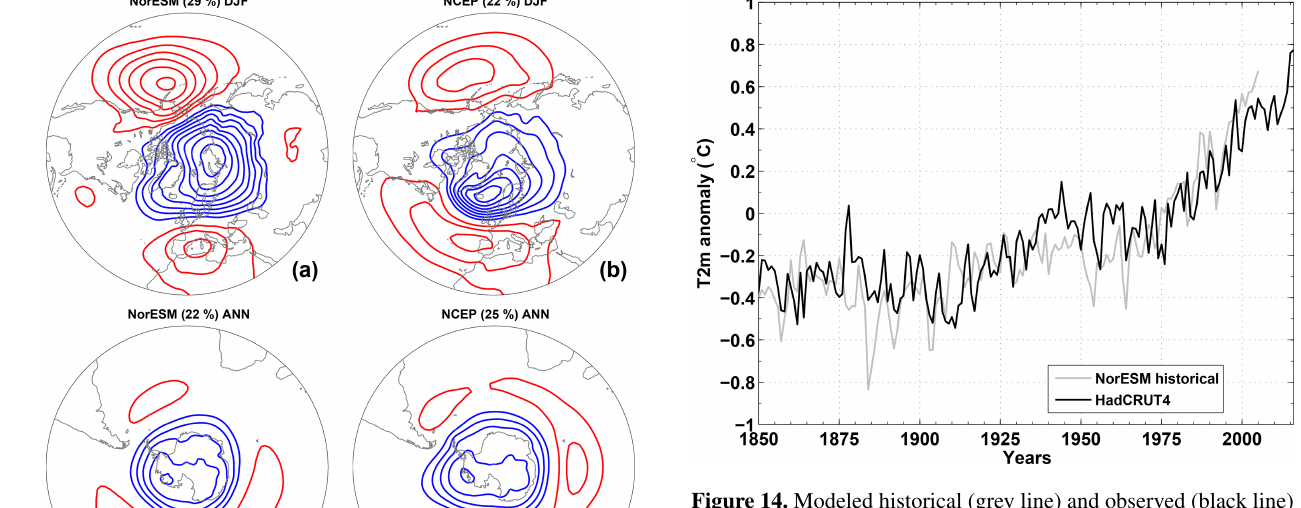
Figure 14. Modeled historical (grey line) and observed (black line) time series of global averaged surface temperature anomalies rela- tive to the period of 1961–1990. Observations are derived from the HadCRUT4 data set (Morice et al.,